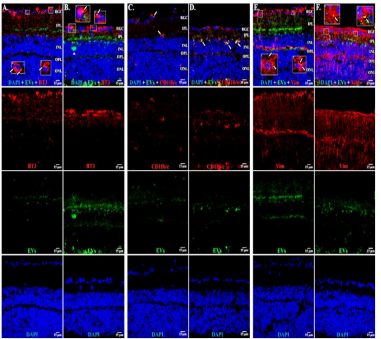
Figure 10. EVs in retinal explants. ( A , B ) BT3 (red), EVs (green), and DAPI (blue) at 6 and 14 days after start of incubation with EVs. ( C , D ) CD11b/c (red), EVs (green), and DAPI (blue) at 6 and 14 days. ( E , F ) vimentin (Vim, red), EVs (green), and DAPI (blue) at 6 and 14 days. Arrows = yellow overlap with EVs; inserts show overlap in detail. RGC = retinal ganglion cell layer; IPL = inner plexiform layer; INL = inner nuclear layer; OPL = outer plexiform layer; ONL = outer nuclear layer. Scale bars (15 µ m) are on bottom right of each panel